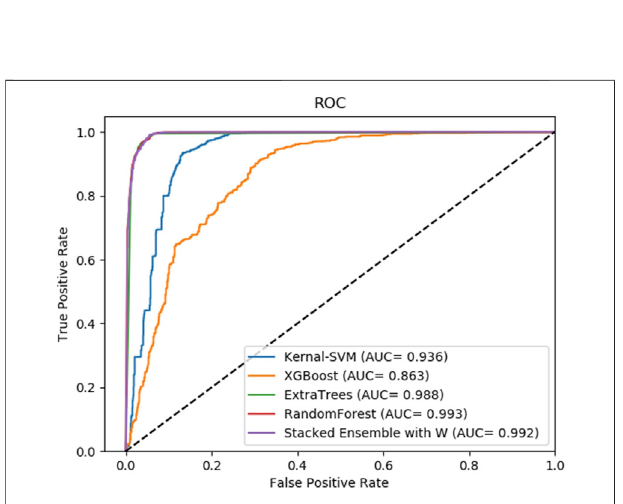
FIGURE 6 | Average result of ROC curves of fi ve-fold cross-validation with four single base classi fi ers and our method of stacking ensemble on RPI1807 by SAWRPI. AUC expresses area under an ROC